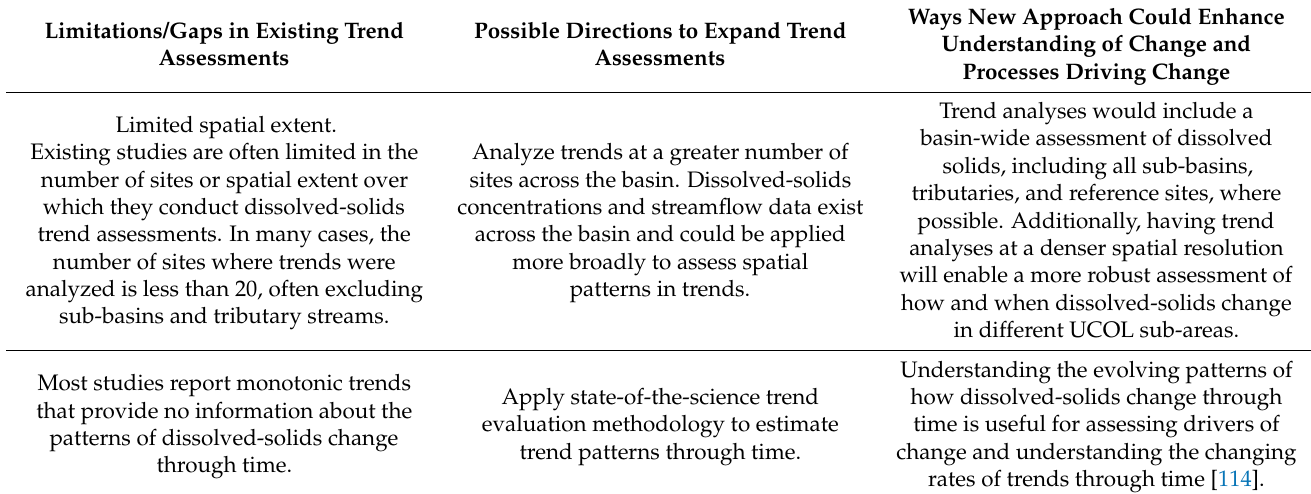
Table 3. Gaps in existing dissolved-solids trend assessments and opportunities for enhancing